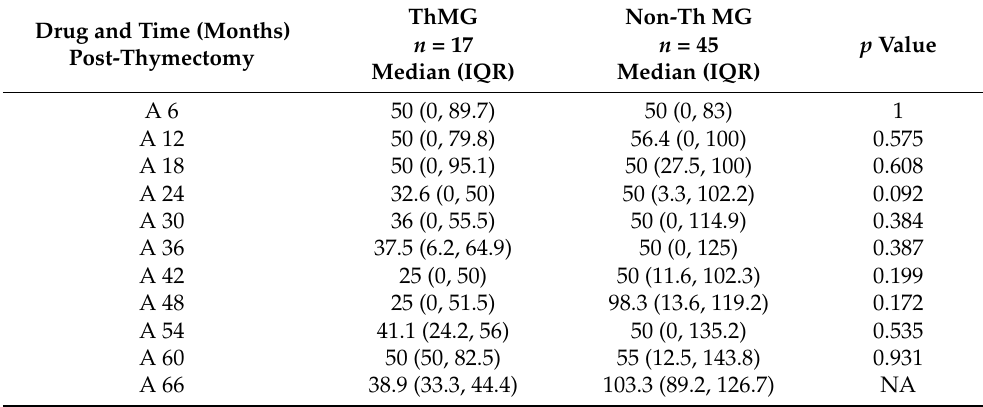
Table 5. Comparison of time-weighted averages (TWAs) of azathioprine (A) dosage requirements (mg/d) after thymectomy between ThMG and non-ThMG